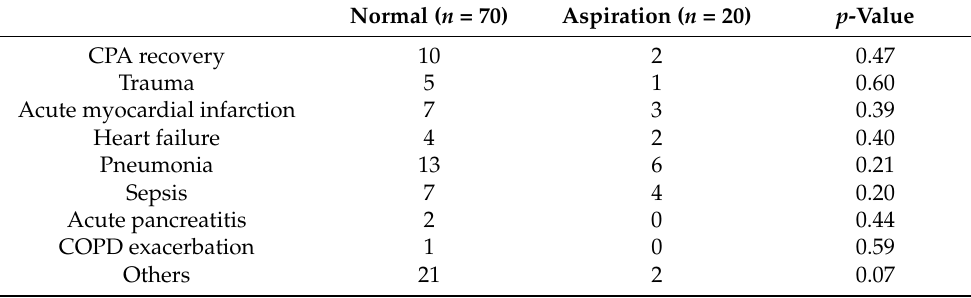
Table 2. The disease background of the patients in the two